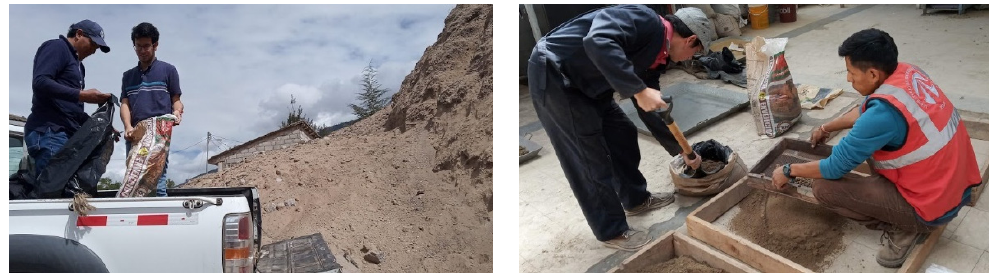
Figure 1. Soil sampling. Table 1. Soil Properties. Table 1. Soil